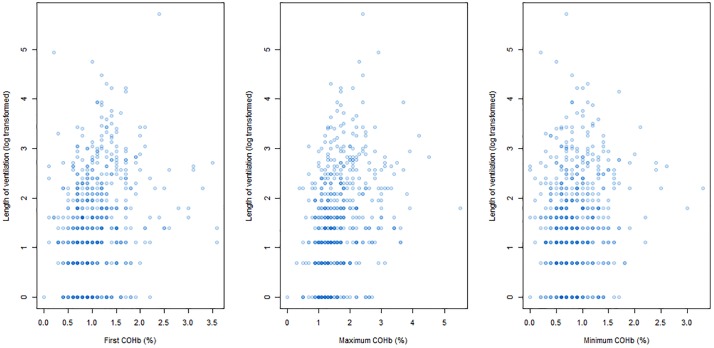
Scatter plot of measured COHb values and length of ventilation (log transformed).The first, minimum and maximum COHb values (%) and the length of ventilation in hours are represented.